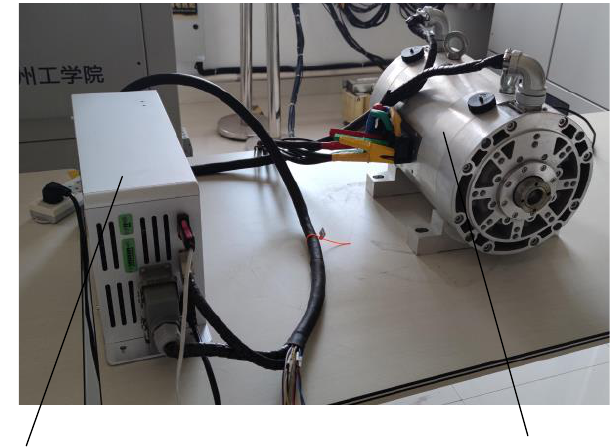
Figure 9. Prototype of six-pole RAHMB suspended flywheel.